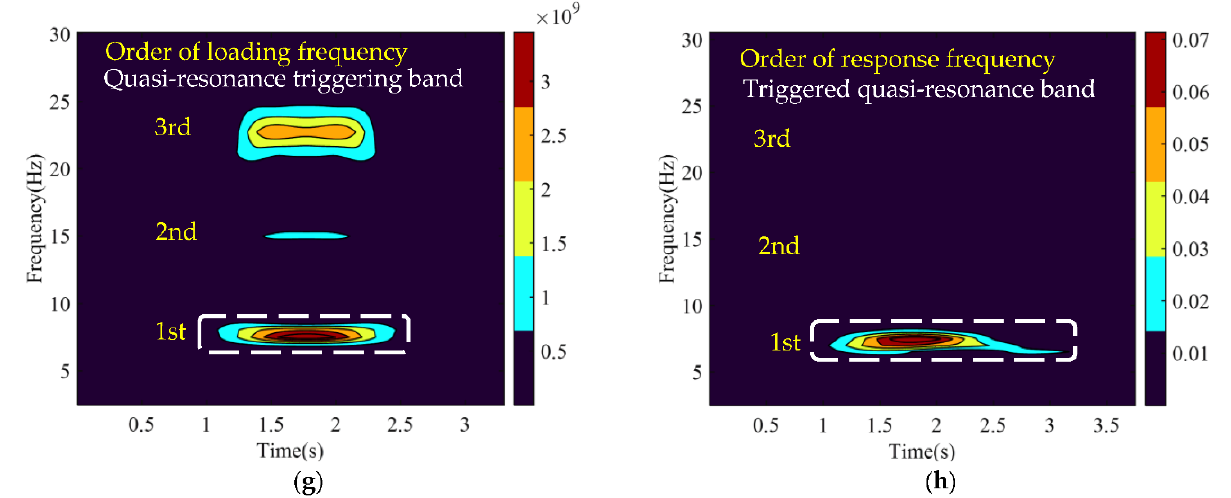
Figure 8. Scalogram from excitation to vertical vibratory resonantly transitional acceleration response at mid–span bridge: ( a ) Excitation scalogram at train speed of 175 km/h; ( b ) Bridge response scalogram at train speed of 175 km/h; ( c ) Excitation scalogram at train speed of 210 km/h; ( d ) Bridge response scalogram at train speed of 210 km/h; ( e ) Excitation scalogram at train speed of 550 km/h; ( f ) Bridge response scalogram at train speed of 550 km/h; ( g ) Excitation scalogram at train speed of 680 km/h; ( h ) Bridge response scalogram at train speed of 680 km/h.